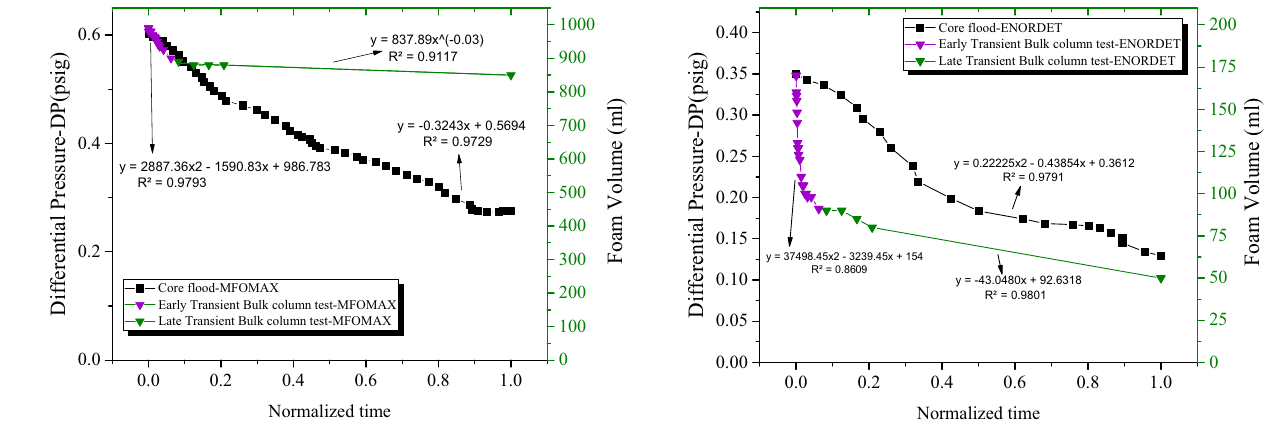
Fig. 8 Side-by-side performance comparison of bulk and coreflood foam stability tests of MFOMAX surfactant